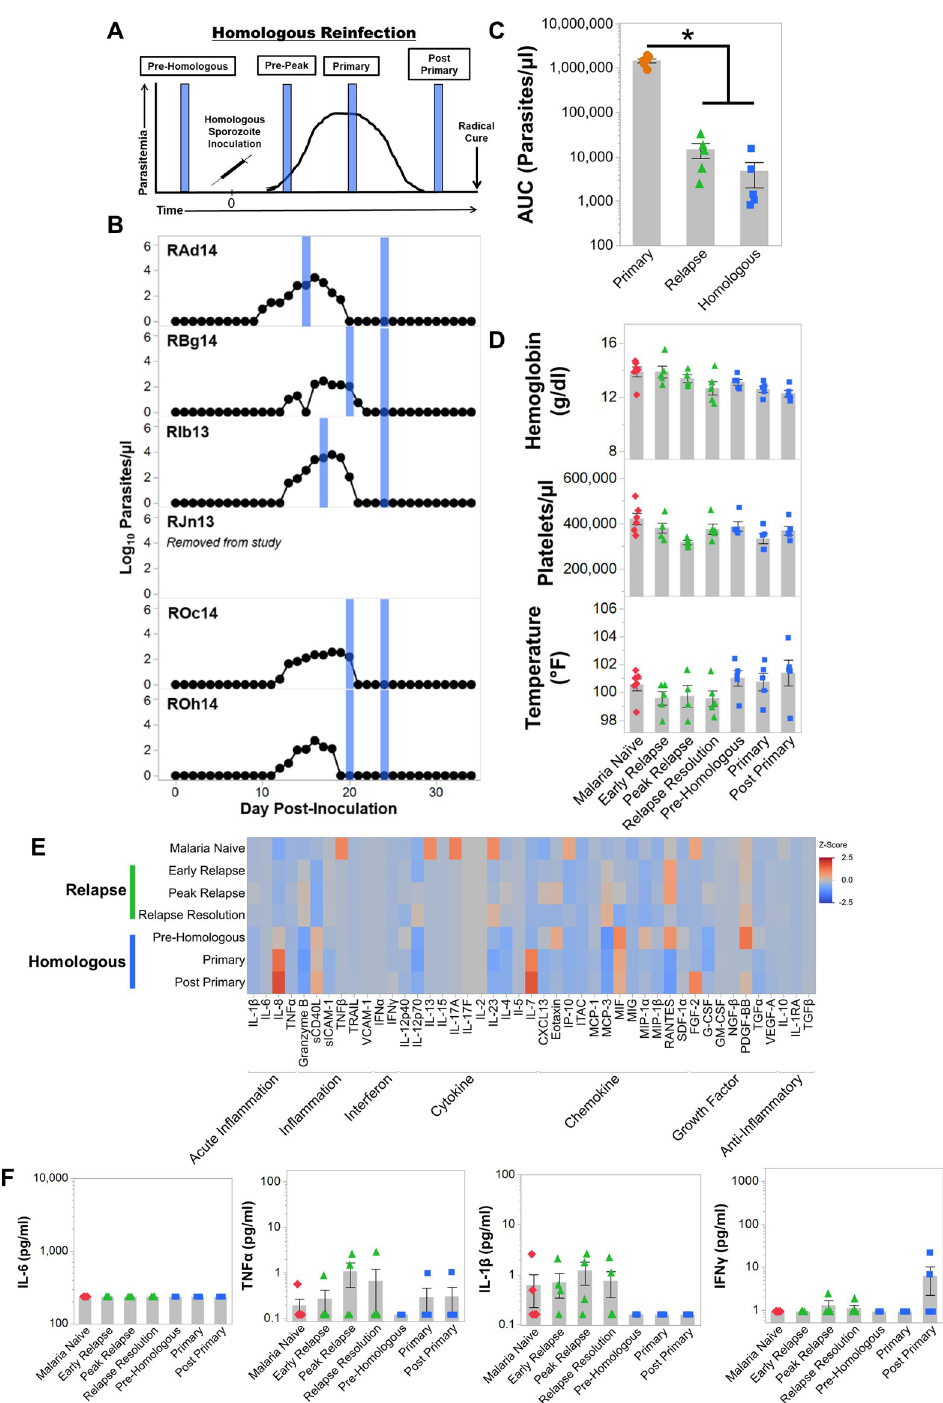
Fig 5. Reinfections with the same P . cynomolgi strain do not result in illness or inflammation. (a) Idealized study design for collecting specimens at different points during a homologous challenge of macaques previously infected with P . cynomolgi M/B strain. (b) Parasite kinetics over a 35-day P . cynomolgi M/B strain homologous challenge in rhesus macaques as determined by Giemsa-stained blood smears. Each row represents a different individual. Colored bars (blue) indicate when sample collections were performed. These collections correspond from left to right with the idealized experimental schematic in panel a. (c) Cumulative parasitemia as determined by area under the curve analysis. (d) Mean hemoglobin levels, reticulocyte concentrations, platelet concentrations, and temperature when